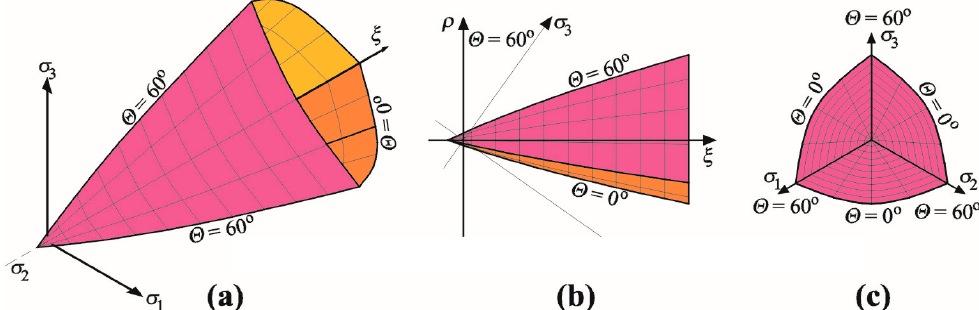
Figure 7. Menétrey–Willam criterion in Haigh–Westergaard space: ( a ) the space of principal stresses, ( b ) hydrostatic cross-section, ( c ) deviatoric section.